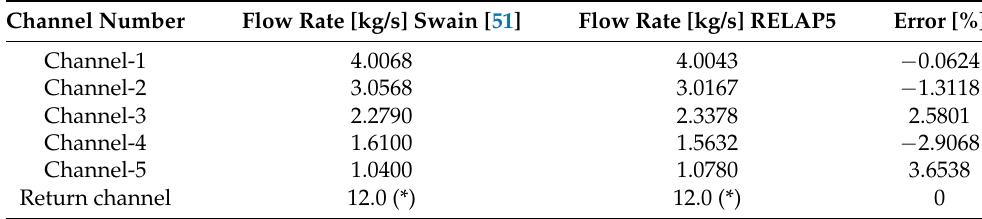
Table 9. Mass flow rate outcomes for ordinary hydro-dynamic case ( B = 0 T ), comparison between CFD analysis and RELAP5. (*) Inlet total mass flow rate as boundary